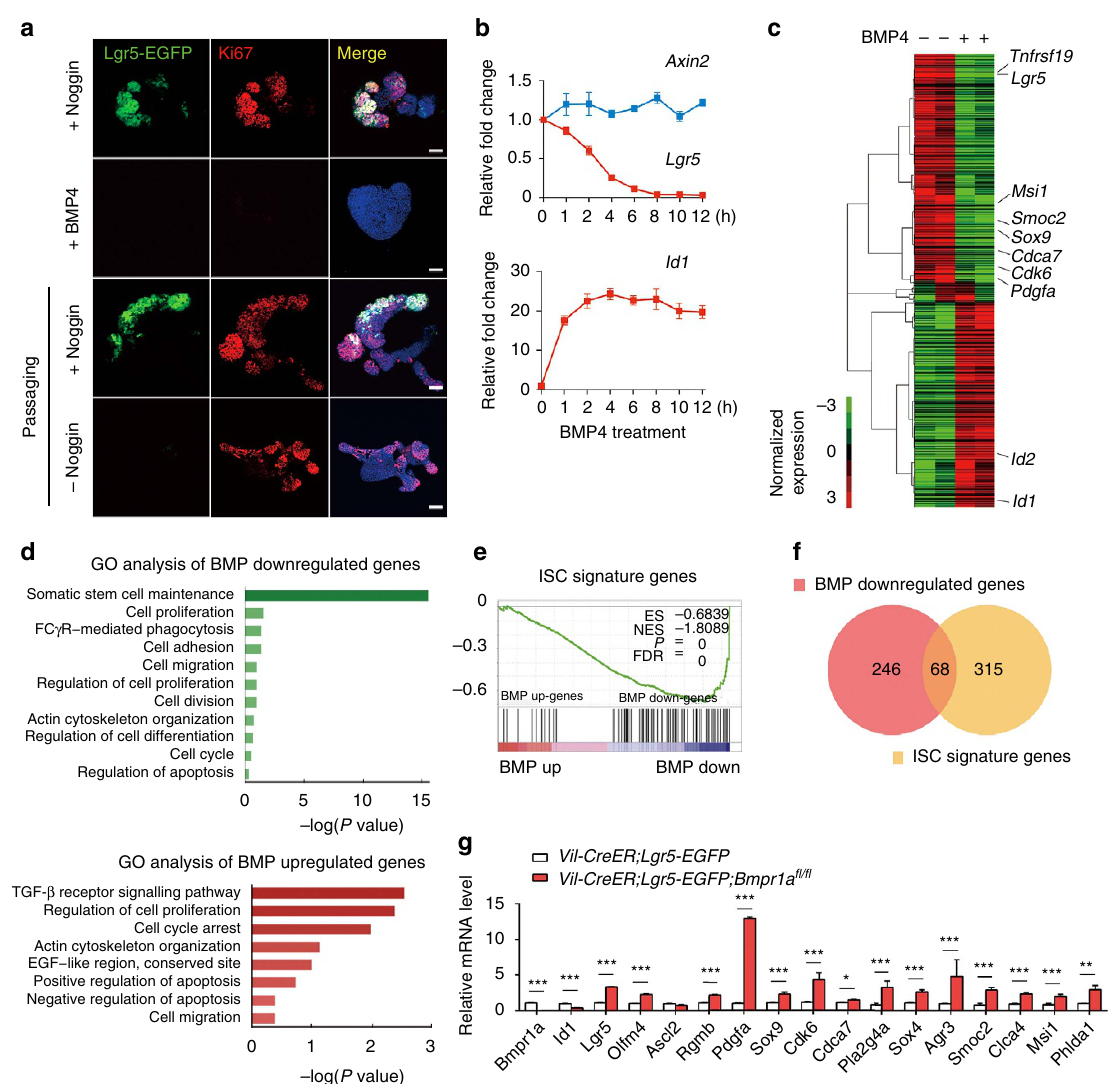
Figure 3 | BMP directly suppresses the expression of Lgr5 þ stem cell signature genes. ( a ) BMP signalling was activated for 36h in intestinal organoids through direct BMP4 treatment or Noggin withdrawal from the normal culture medium containing EGF, Noggin and R-spondin after cell passaging. Lgr5 þ stem cells (Lgr5-EGFP) and proliferating cells (Ki67 þ ) were examined in the organoids. Nuclei were counter-stained with 4 0 ,6-diamidino-2-phenylindole. Images are representative of three independent experiments. ( b ) Quantitative RT–PCR analysis of Lgr5 , Axin2 and Id1 in intestinal organoids after BMP stimulation for indicated time. ( c ) The organoids derived from Lgr5-EGFP mice were treated with 10ngml (cid:2) 1 BMP4 for 4h, and then Lgr5 þ stem cells were isolated by FACS and subjected to RNA-seq. Heatmap of RNA-seq data shows the downregulation of known ISC marker genes by BMP. ( d ) GO analysis of BMP-downregulated genes and BMP-upregulated genes in Lgr5 þ stem cells, respectively. ( e ) GSEA revealed significant enrichment of ISC signature gene set with BMP-downregulated genes. ES, enrichment score; NES, normalized enrichment score. ( f ) Venn diagram showing the overlap between ISC signature genes with BMP-downregulated genes. ( g ) Quantitative RT–PCR analysis of stem cell signature gene expression in Lgr5 þ stem cells sorted from mice with indicated genotypes at day 12. Data represent mean ± s.e.m of n ¼ 5 mice. * P o 0.05, ** P o 0.01, *** P o 0.001 by Student’s t -tests. Scale bars, 50 m